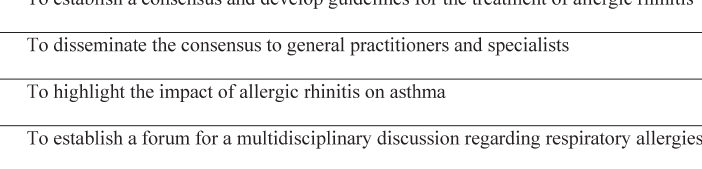
Figure 9 - Objectives of the Allergic Rhinitis and its Impact on Asthma initiative.